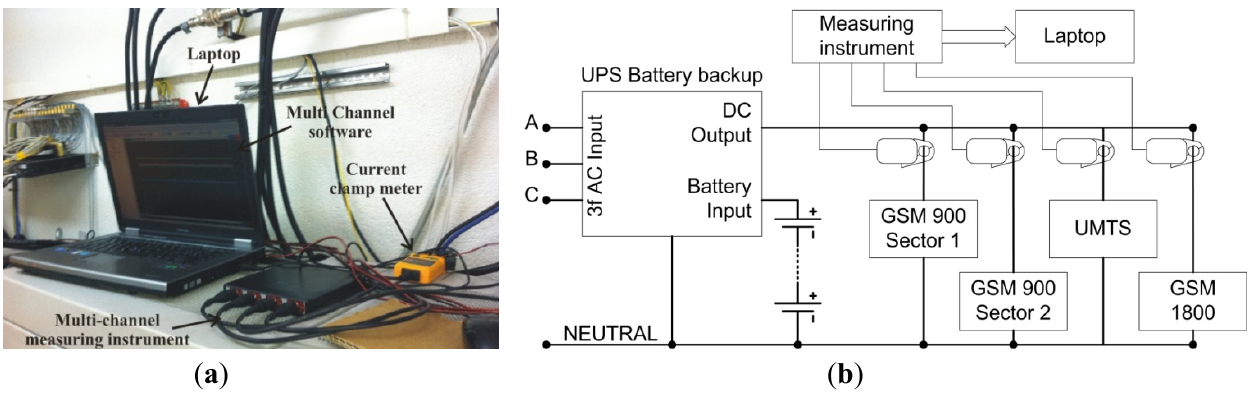
Figure 2. ( a ) Snapshot and ( b ) block diagram of measurement setup used for measuring instantaneous DC electric current consumption of BSs.